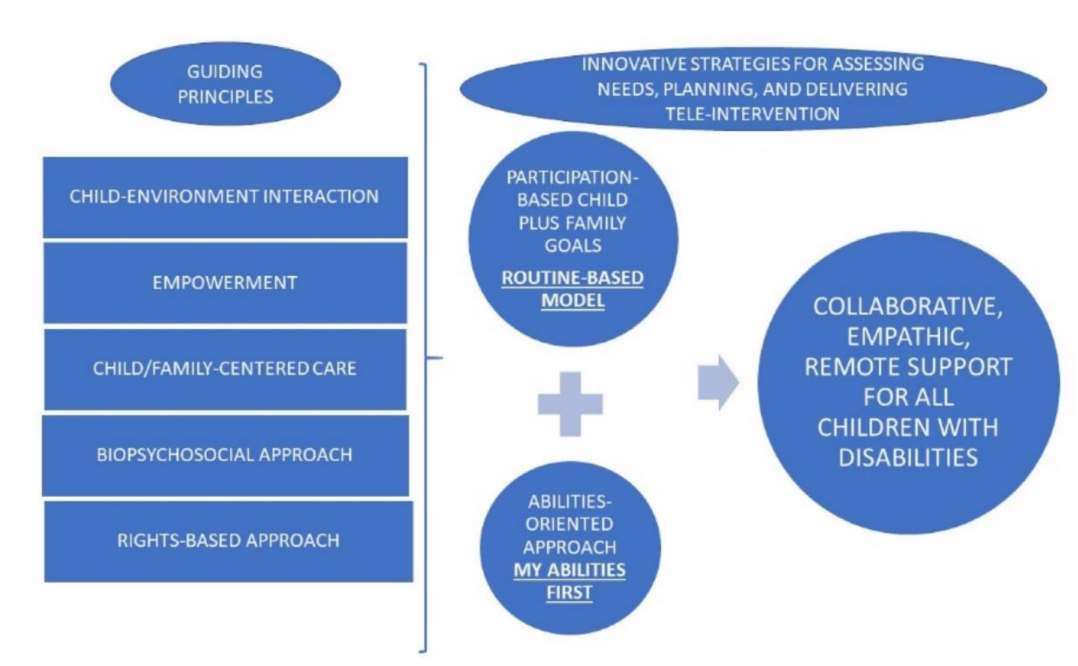
Figure 1. Innovative strategies for delivering remote support for all children with